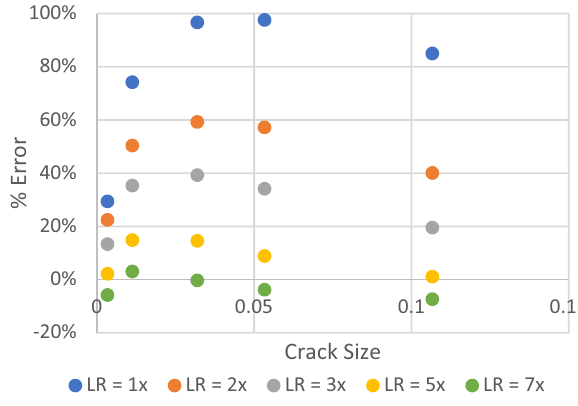
Fig. 15 Error in stress intensity factors for plate with 120-degree v-notch